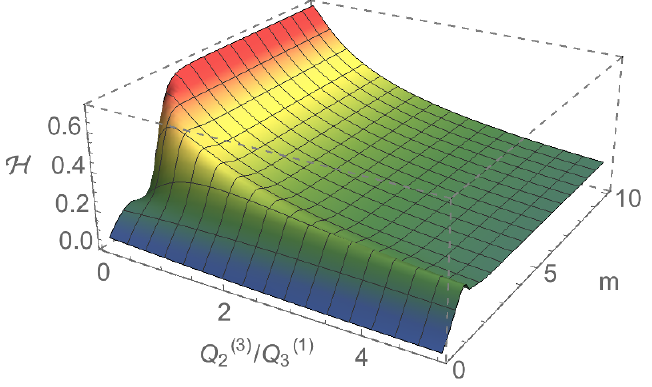
(3) and the initial hierarchy parameter m 2 Q (1) 3